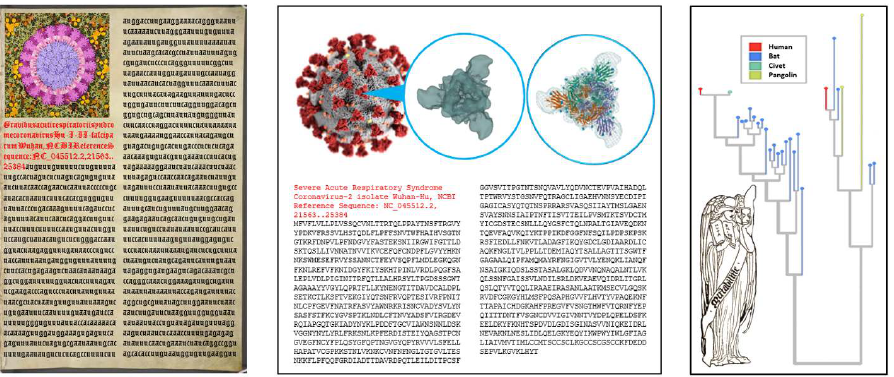
Figure 1: LEFT . Painting and Letters (Partial Transcript) of the Novel Coronavirus Responsible for COVID-19. MIDDLE . Electron Micrographs and Partial Translation of the Coronavirus and Trimeric Spike Protein. RIGHT. Mutability Overseeing a Phylogeny (Evolutionary Tree) of Coronavirus Strains, Colored According to their Host